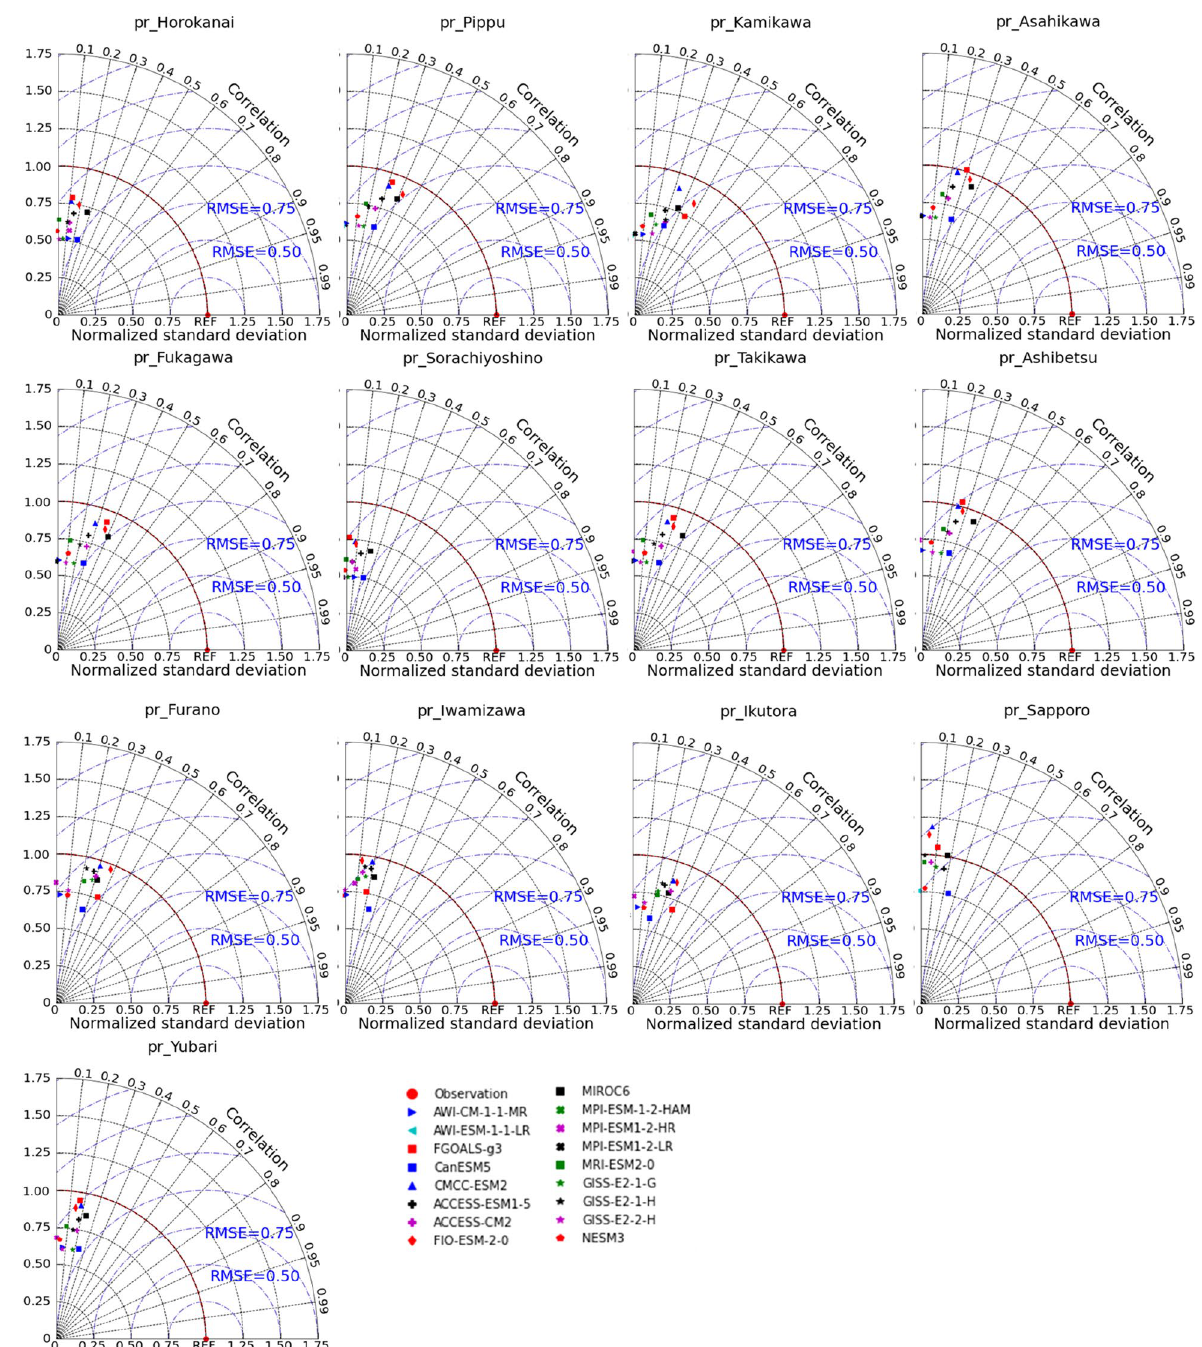
Figure 4. Taylor diagrams of precipitation (pr) for each GCM at each